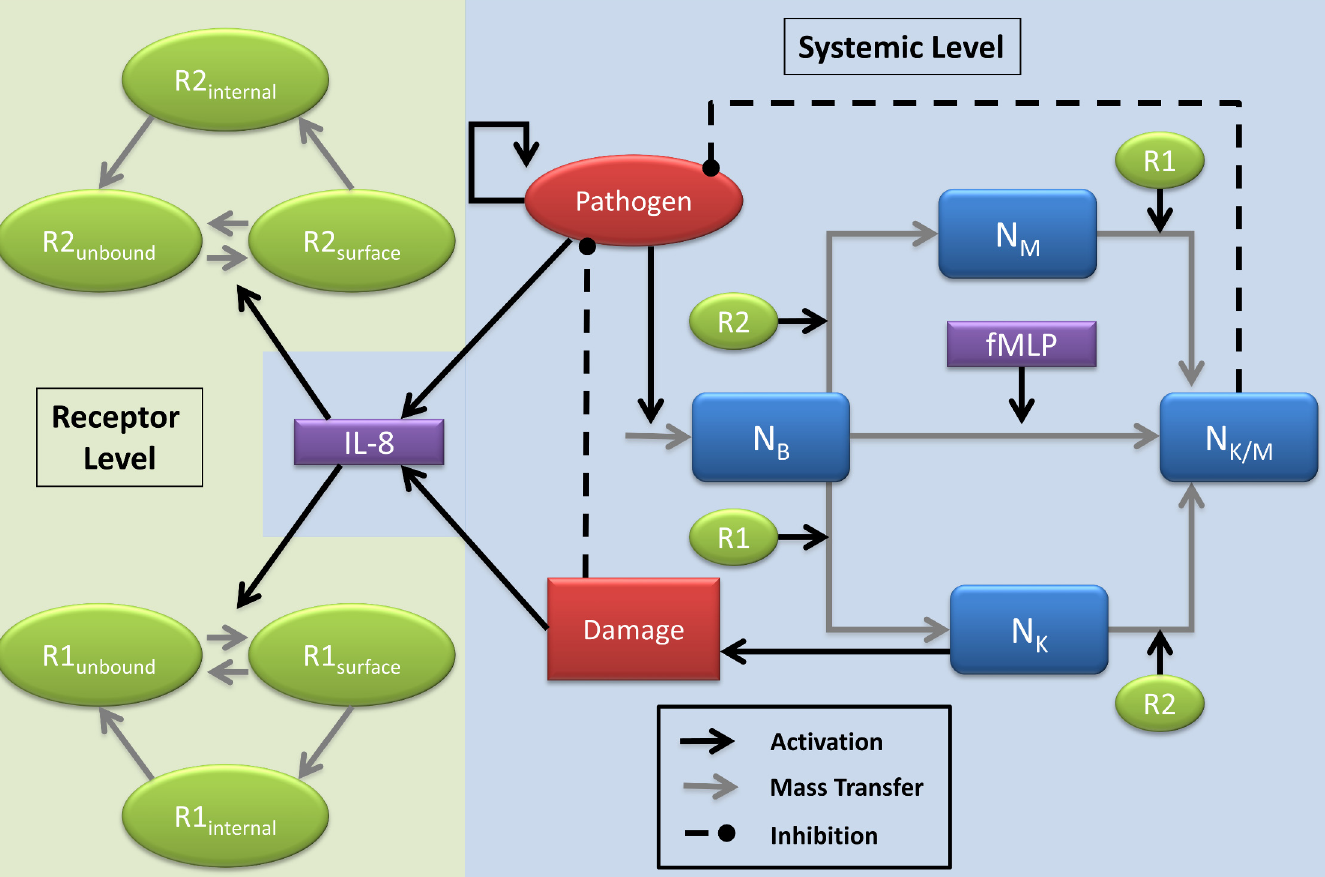
Fig 1. Model diagram detailing neutrophil phenotypes and critical feedback loops. The system is divided into modules based on the level at which the interactions occur. The systemic level includes the interactions between the pathogen (P), four neutrophil phenotypes (basal: N B, migratory: N M , killing: N K and killing and migratory: N K/M ) and chemokine IL-8. The receptor level interactions include the intracellular dynamics of CXCR-1/2, namely activation, internalization and recycling. Two types of feedback occur between the two levels, active surface receptors can trigger the phenotype conversion of the neutrophils and IL-8 produced at the systemic level triggers the trafficking of the receptors. A CXCR-1/2 independent activation via fMLP is included to model general pro-inflammatory response. The systemic damage (D) indicates the overall damage (direct and indirect) caused by the action of the killer neutrophils.